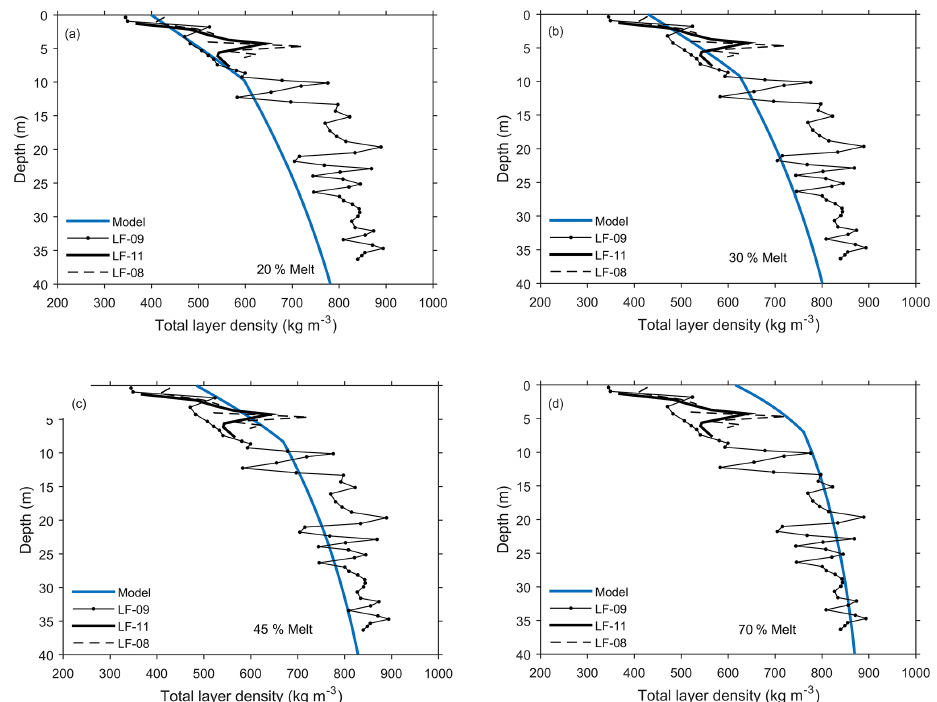
Figure 15. Comparison between the LF-08, LF-09 and LF-11 ice core density profiles (annual averages) and the output of the firn- densification model (Reeh et al., 2005), considering: (a) 20% of melt, (b) 30% of melt, (c) 45% of melt, and (d) 70% of melt.